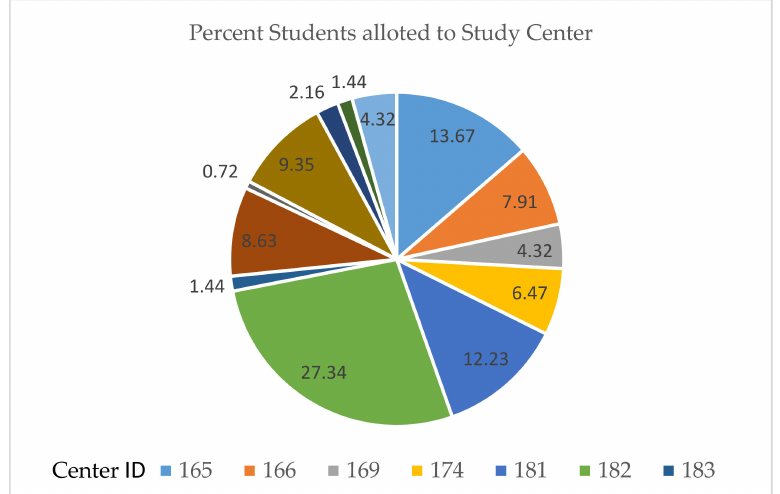
Figure 8. Percentage of students assigned to each study